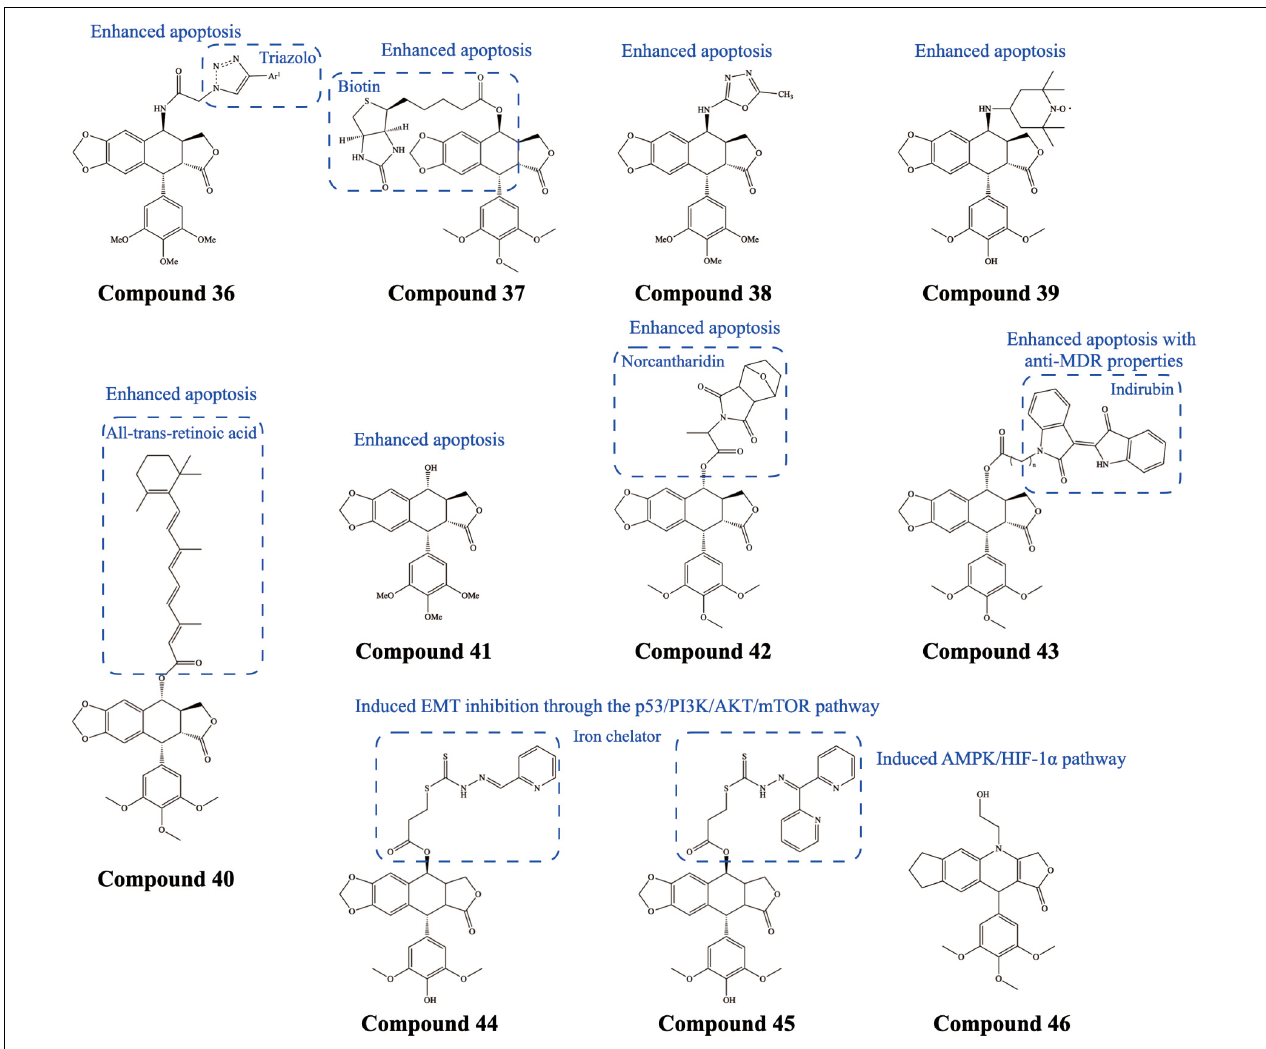
FIGURE 10 | Chemical structures and therapeutic highlights of PTOX derivatives Compound